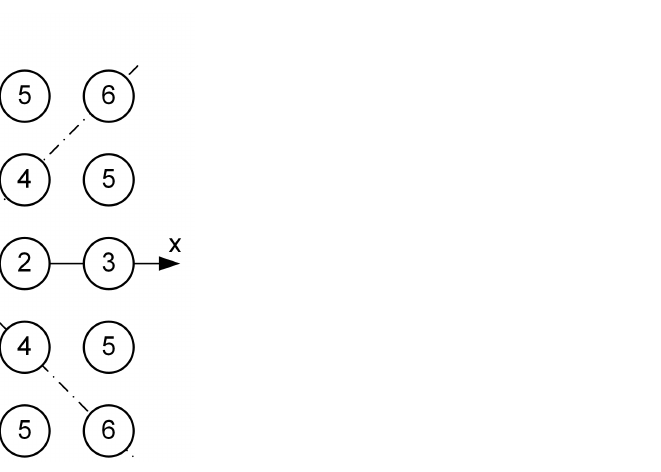
Figure 4. BTES with 5 × 5 = 25 probes. Probes with the same number behave thermally identically. Adapted from